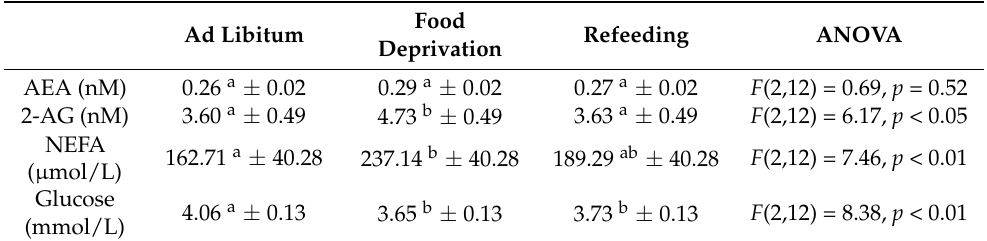
Table 2. Plasma endocannabinoid (AEA, 2-AG), NEFA and glucose concentrations of 7 cows with ad libitum intake, after 7 h of food deprivation and 17 h after refeeding. Cows were offered a corn silage-based diet. Data are shown as LSM +